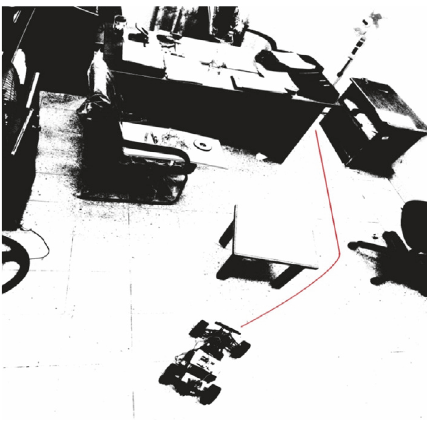
Figure 27: Trajectory path planning.